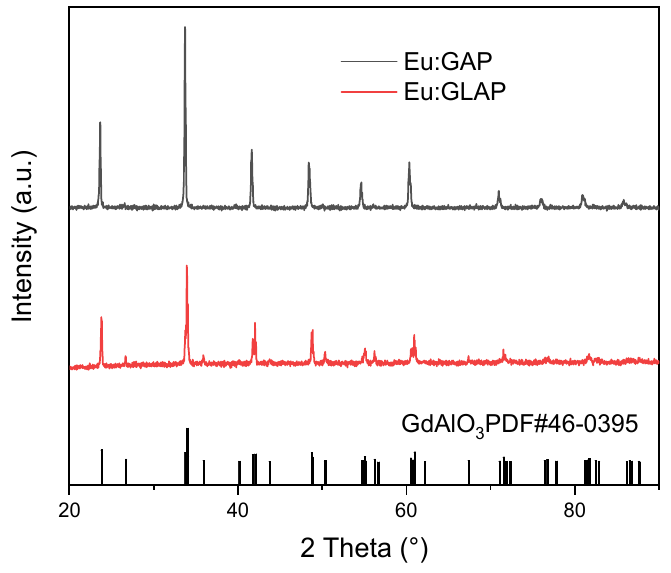
Figure 2. PXRD patterns of the as-grown Eu:GAP and Eu:GLAP single crystals. Figure 3 gives the Laue photograph of the Eu:GAP and Eu:GLAP crystals, as grown and after the air annealing process. The clear and well symmetric diffraction patterns demonstrated a high single crystal quality.